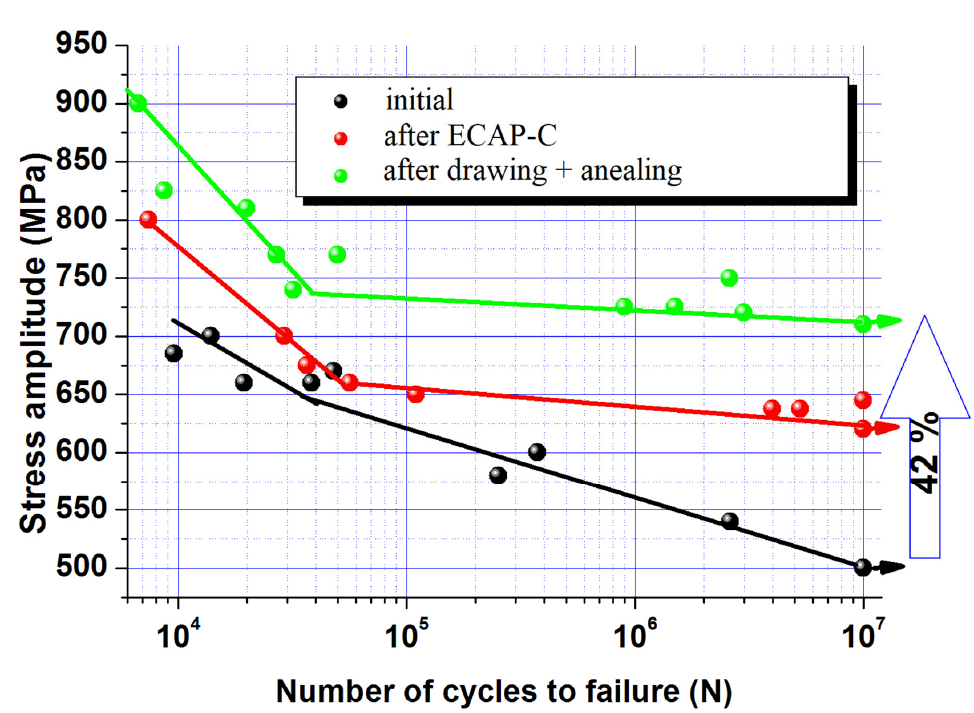
Figure 10. Fatigue curves of the Ti-15Mo alloy in the initial state, after ECAP-C, and after the combined thermomechanical treatment, including ECAP-C and drawing.